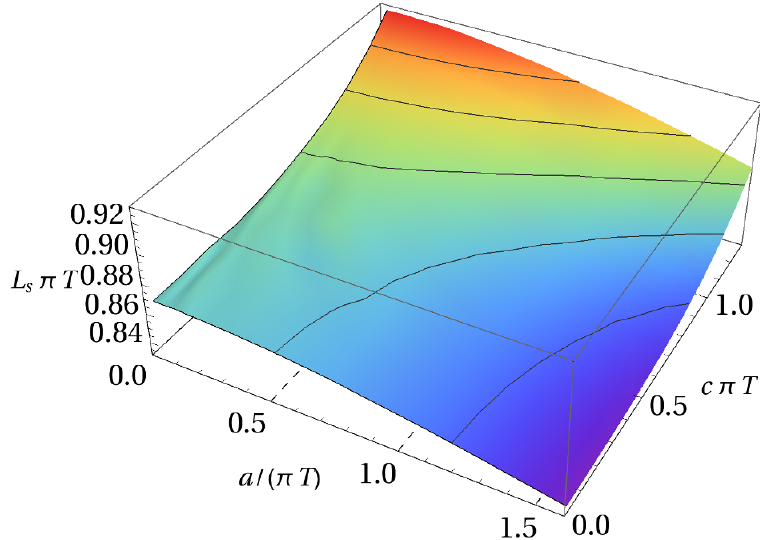
Figure 7 . The screening distance as a function of the two parameters c and a of our model for a q (cid:22) q -pair lying parallel to the anisotropic direction. L s increases for growing c and decreases for growing a .